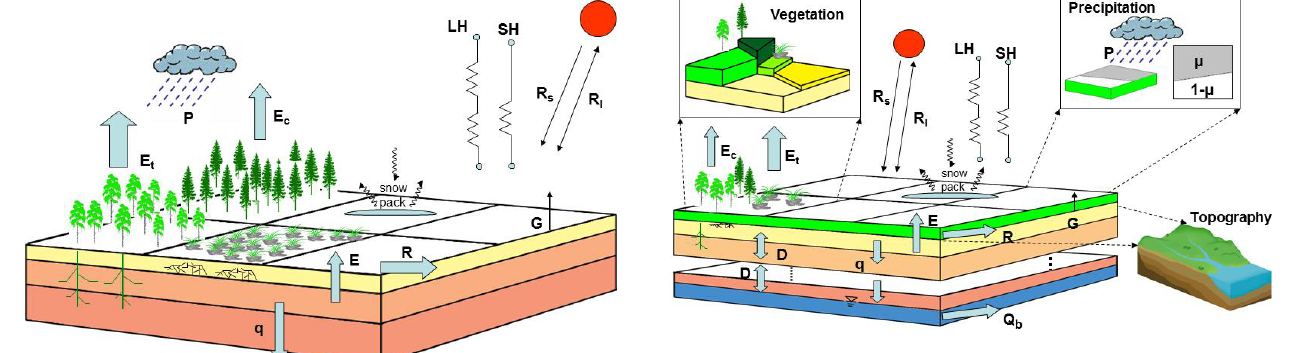
Figure 2. Schematic of “generation 2B” LSMs. See Fig. 1 for basic symbols. In addition, subgrid variabilities of precipitation, vegeta- tion type, soil properties and topography are represented statistically ( µ represents the variable precipitation-covered area) and hydro- logical processes are represented more explicitly. Thus surface and subsurface runoff ( Q b and q ) are distinguished, and diffusion ( D ), lateral flow in the subsurface ( Q b ), and groundwater table dynamics are also modelled.